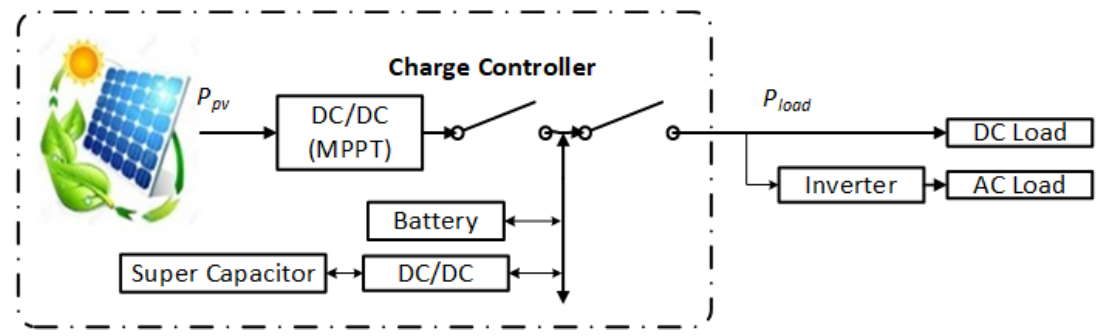
Figure 9. SC semi-active HESS supported autonomous PV system.